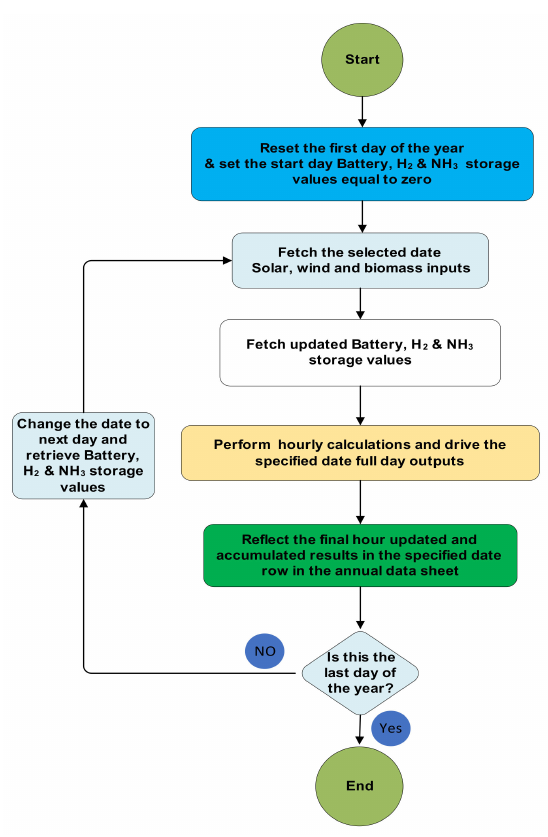
Figure 7. Operation priority flowchart.